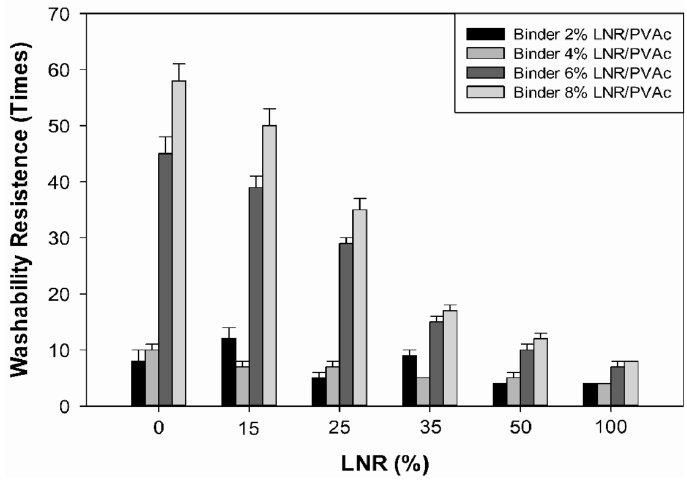
Figure 2. Washability resistance of emulsion paints with LNR/PVAc mixed binder. Figure 3 shows a decrease in the washability resistance properties and the increase in the NRL-g-(MMA-co-St) levels in the emulsion paint binder. This means that the adhesion properties of NRL-g-(MMA-co-St) are still lower than those of PVAc. However, NRL-g- (MMA-co-St) had better adhesion properties than either unmodified NRL or LNR. The washability resistance of LNR is much lower than that of NRL-g-(MMA-co-St) at the same composition of binder mixture and binder content of emulsion paint. This is because NRL-g-(MMA-co-St) has a better affinity between particles and water resistance than LNR [16].